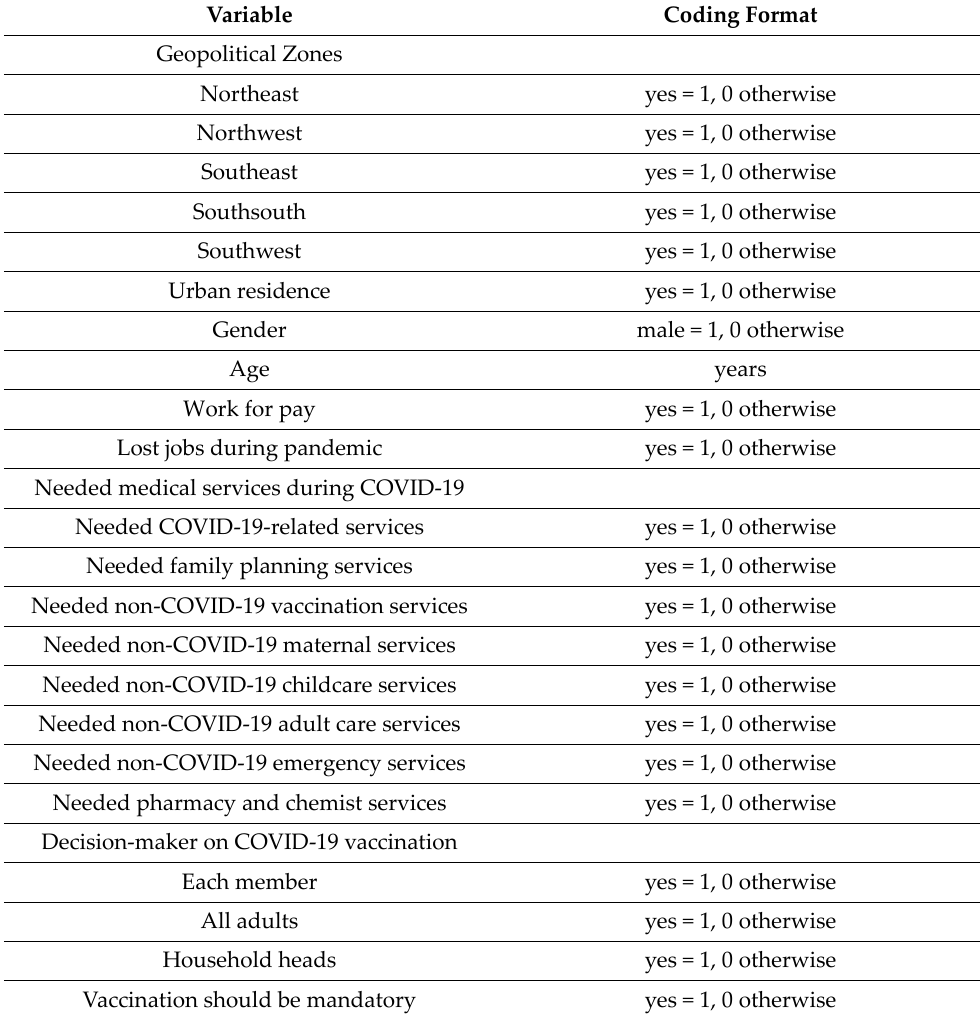
Table 1. Coding formats of the independent